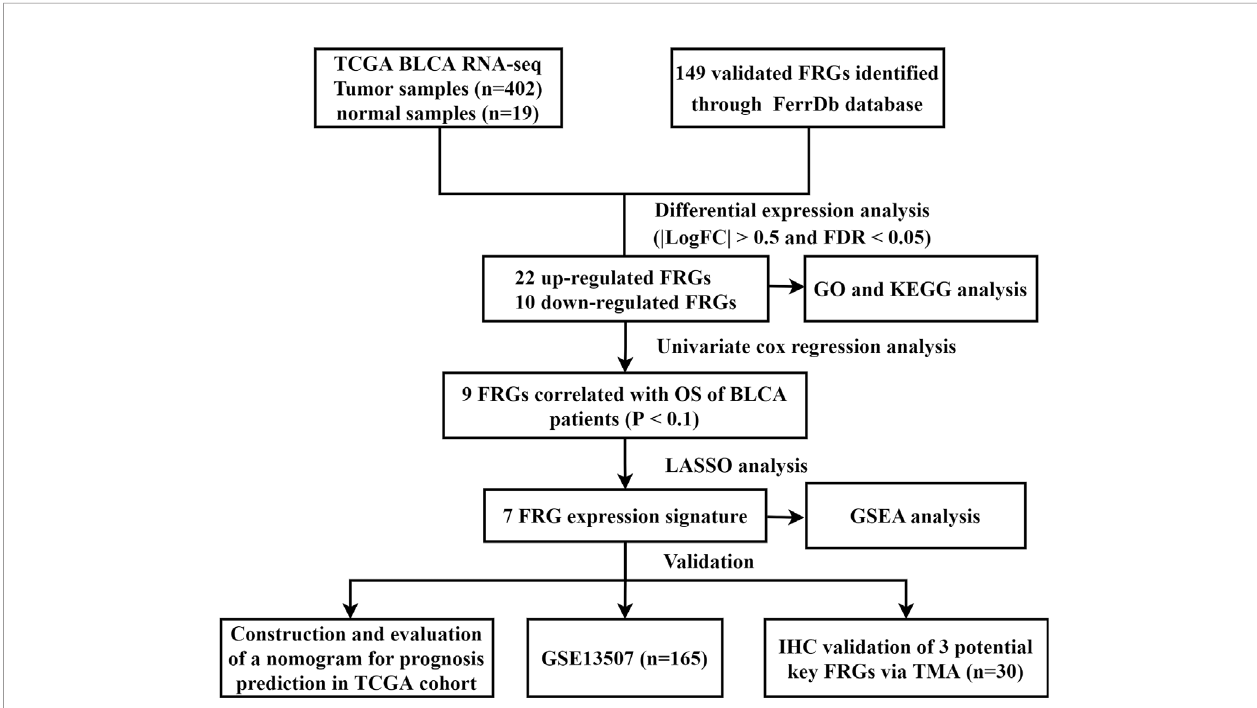
FIGURE 10 | Flow chart of data collection and analysis. TCGA, The Cancer Genome Atlas; BLCA, bladder cancer; FRG, ferroptosis − related gene; GO, gene ontology; KEGG, Kyoto Encyclopedia of Genes and Genomes; OS, overall survival; LASSO, least absolute shrinkage and selection operator; GSEA, Gene Set Enrichment Analysis; IHC, immunohistochemistry; TMA, tissue